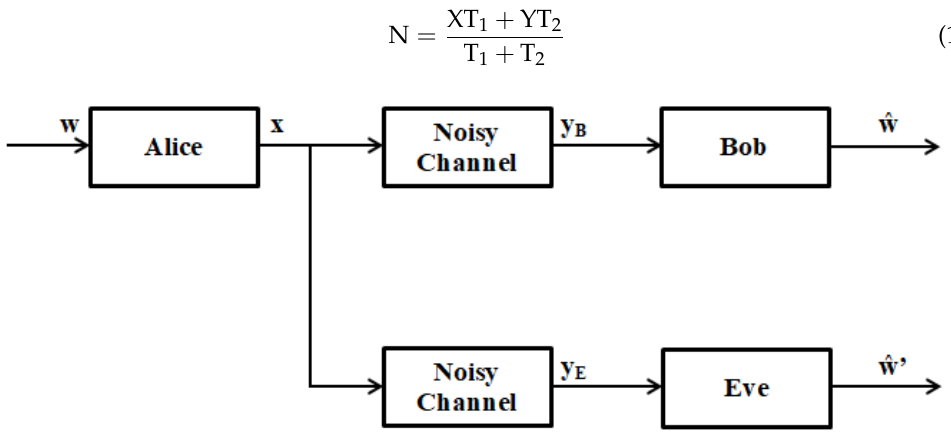
Figure 1. Eavesdropping channel model introduced by